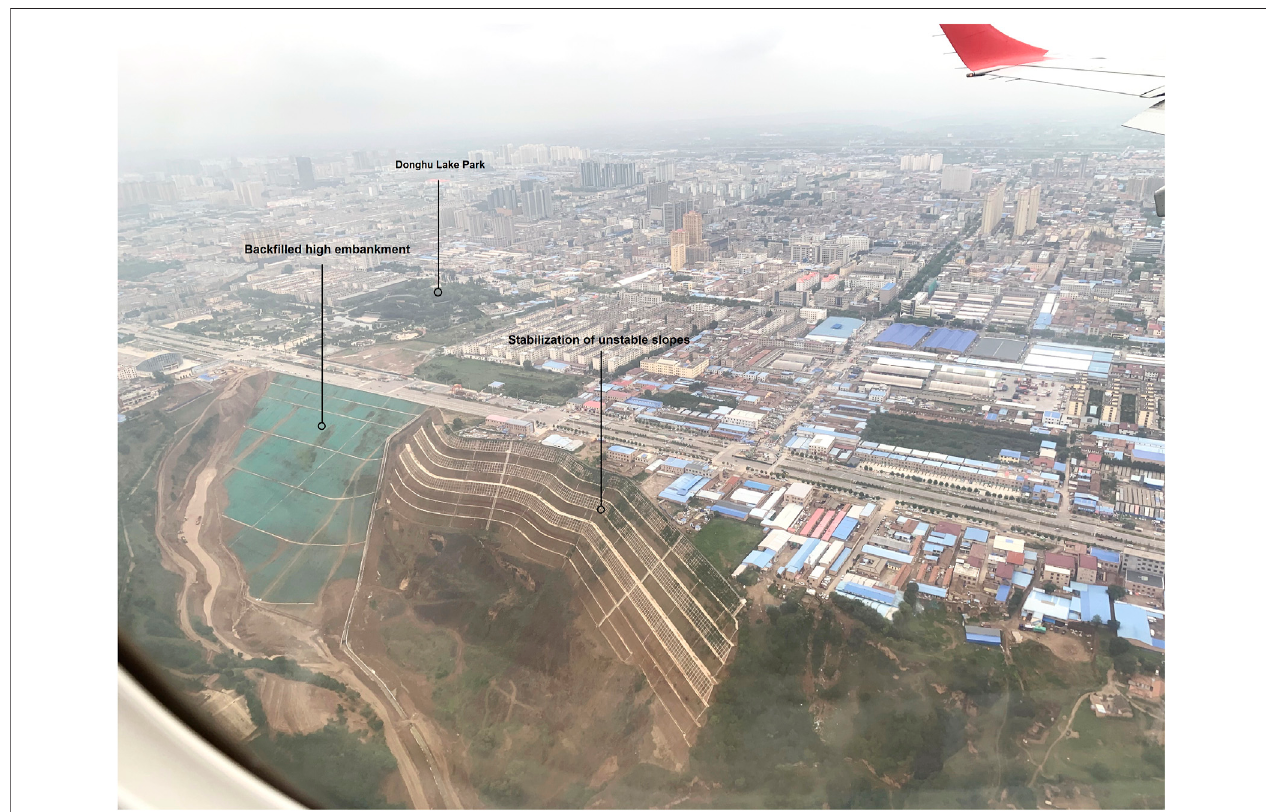
FIGURE 5 | Geohazard control engineering at Huohanggou Gully as seen from an airplane.